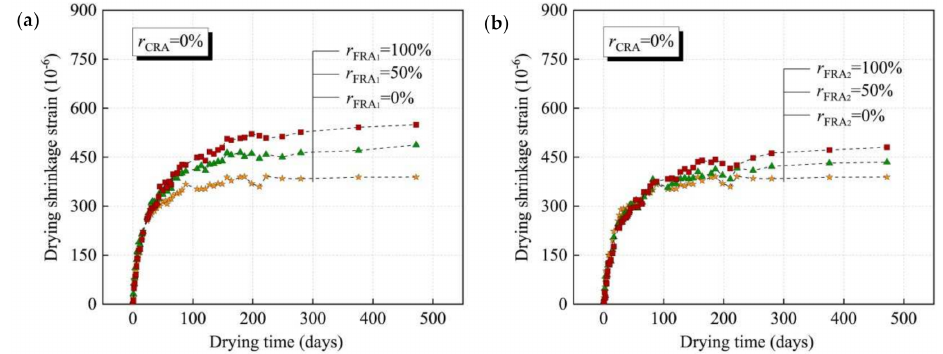
Figure 3. Development of dry shrinkage of concrete with time using different sources of FRA [61]: ( a ) concrete with FRA1, rCRA = 0%; ( b ) concrete with FRA2, rCRA =